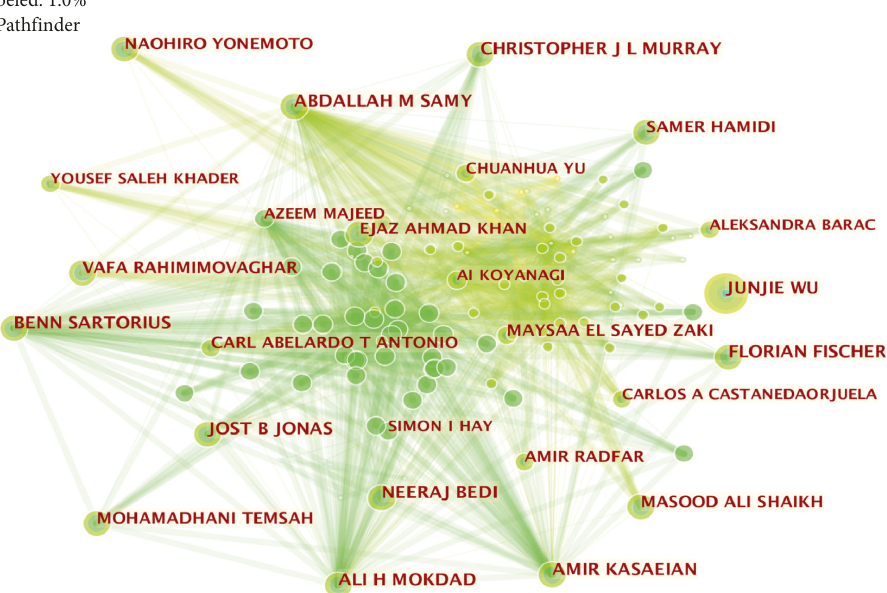
Figure 8: Authors’ cooperation network of international DEM